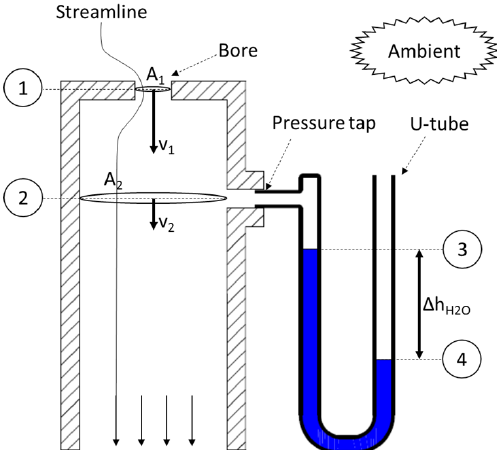
Figure 3. Orifice plate calibrator.